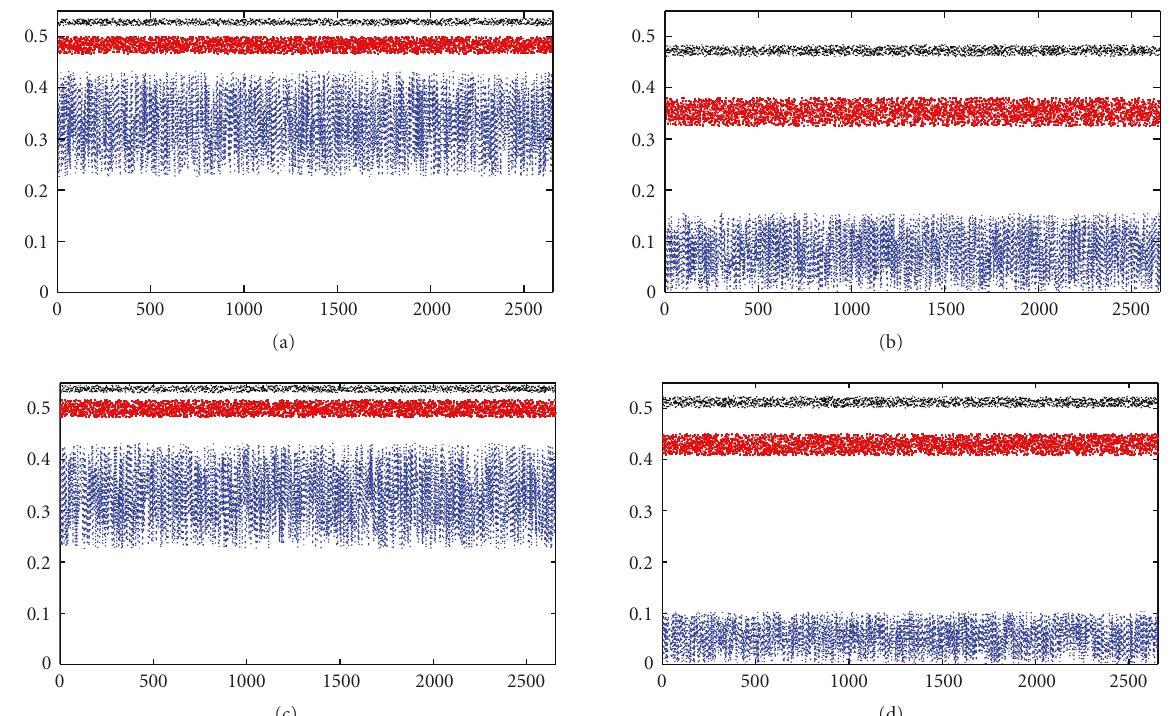
Figure 16: Hamming distance of match (blue,bottom), nearest nonmatch (red, middle), and average nonmatch (black, top) of (a) Daugman [5], (b) Monro et al. [15], (c) Ma et al. [7], and (d) proposed method using CASIA-IrisV3 interval database.